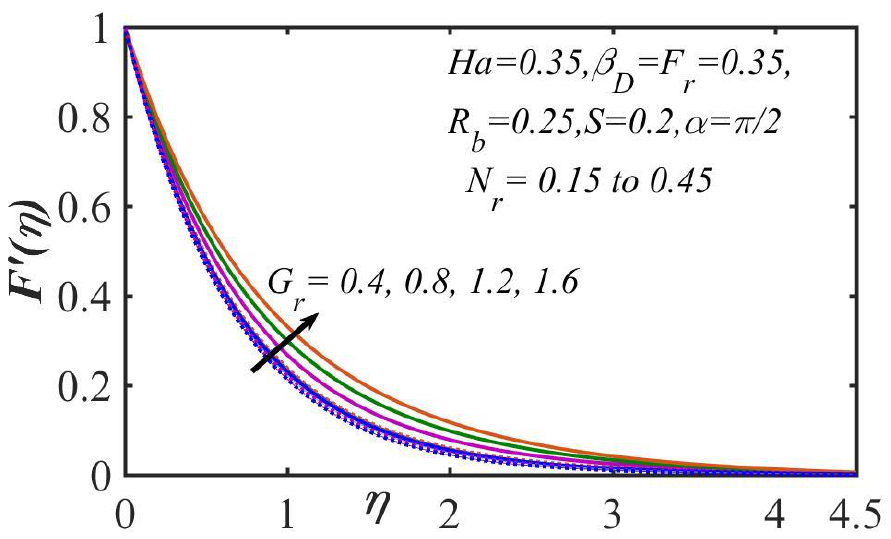
Figure 3. Variation of 𝐹 𝑟 and 𝛽 𝐷 on velocity magnitudes. Solid curve: 𝛽 𝐷 = 0.25 ; dotted curve: 𝛽 𝐷 = 1.25 .